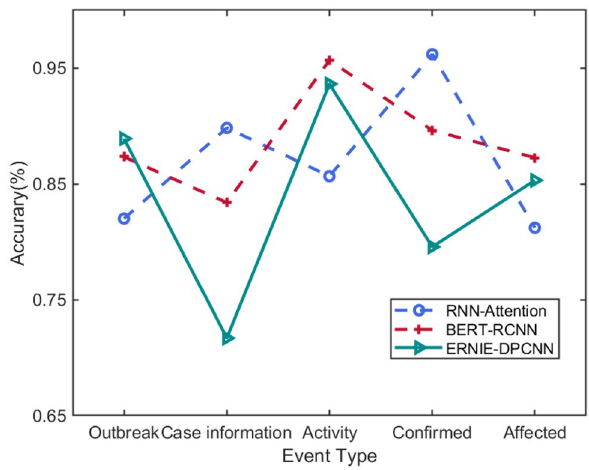
Fig. 4 Results of ETI baselines